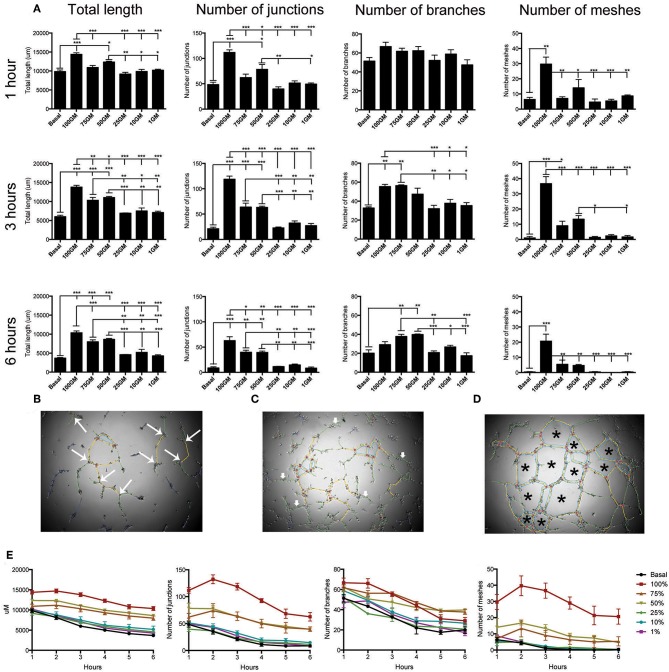
Quantification of tube angiogenic parameters over a 6 h tube forming experiment on Matrigel. Total tube length and the number of junctions, branches and meshes were analyzed over the 6 h of the tube formation experiment where hBECs were seeded at 5,000 cells/well on Matrigel in a 96 well-plate (A). All parameters were significantly increased with the use of 100% GM as compared to basal media at all time points, with the exception of the number of branches at 1 h and 6 h. Maximal significant between all parameters and GM concentrations occurred at 3 h. The parameters that are included in this analysis were visualized as the number of junctions (large arrows, B). Branches did not make connections with any other tube (small arrows, C). Meshes are comprised of the complete joining of multiple segments and junctions (asterisk, D) Regardless of culture medium concentration, tube length, number of junctions, number of branches and number of meshes significantly decreased over the 6 h of the experiment (E). p < 0.05 1 h vs. 6 h all growth medium concentrations (n = 3, in triplicate). GM, growth media, *p < 0.05, **p < 0.01, ***p < 0.001. Scale bar: 500 μm.